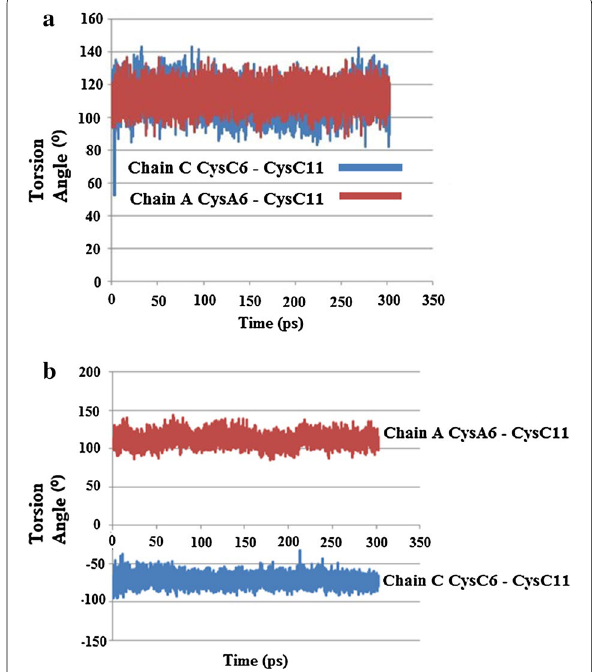
Fig. 21 a Plot of torsion angle χ3 changes for Cys6–Cys11 for the major conformation in HR insulin, Insugen (I) for the MD simulation carried out at 320 K. b Plot of torsion angle χ3 changes for Cys6– Cys11 for the minor conformation in HR insulin Insugen (I) for the MD simulation carried out at 320 K